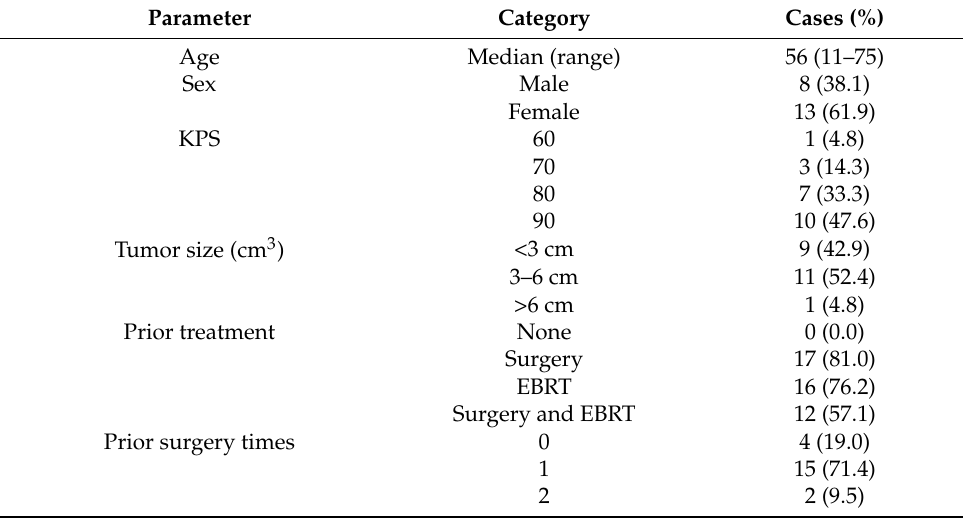
Table 1. General information for the 21 patients in this